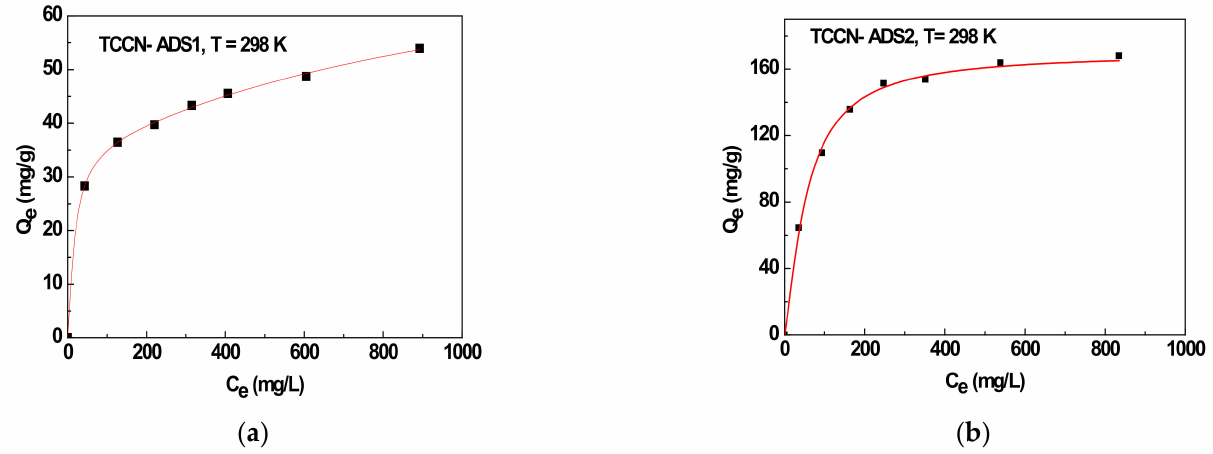
Figure A1. Examples of adsorption data fitting; ( a ) TCCN-ADS1 ( b )